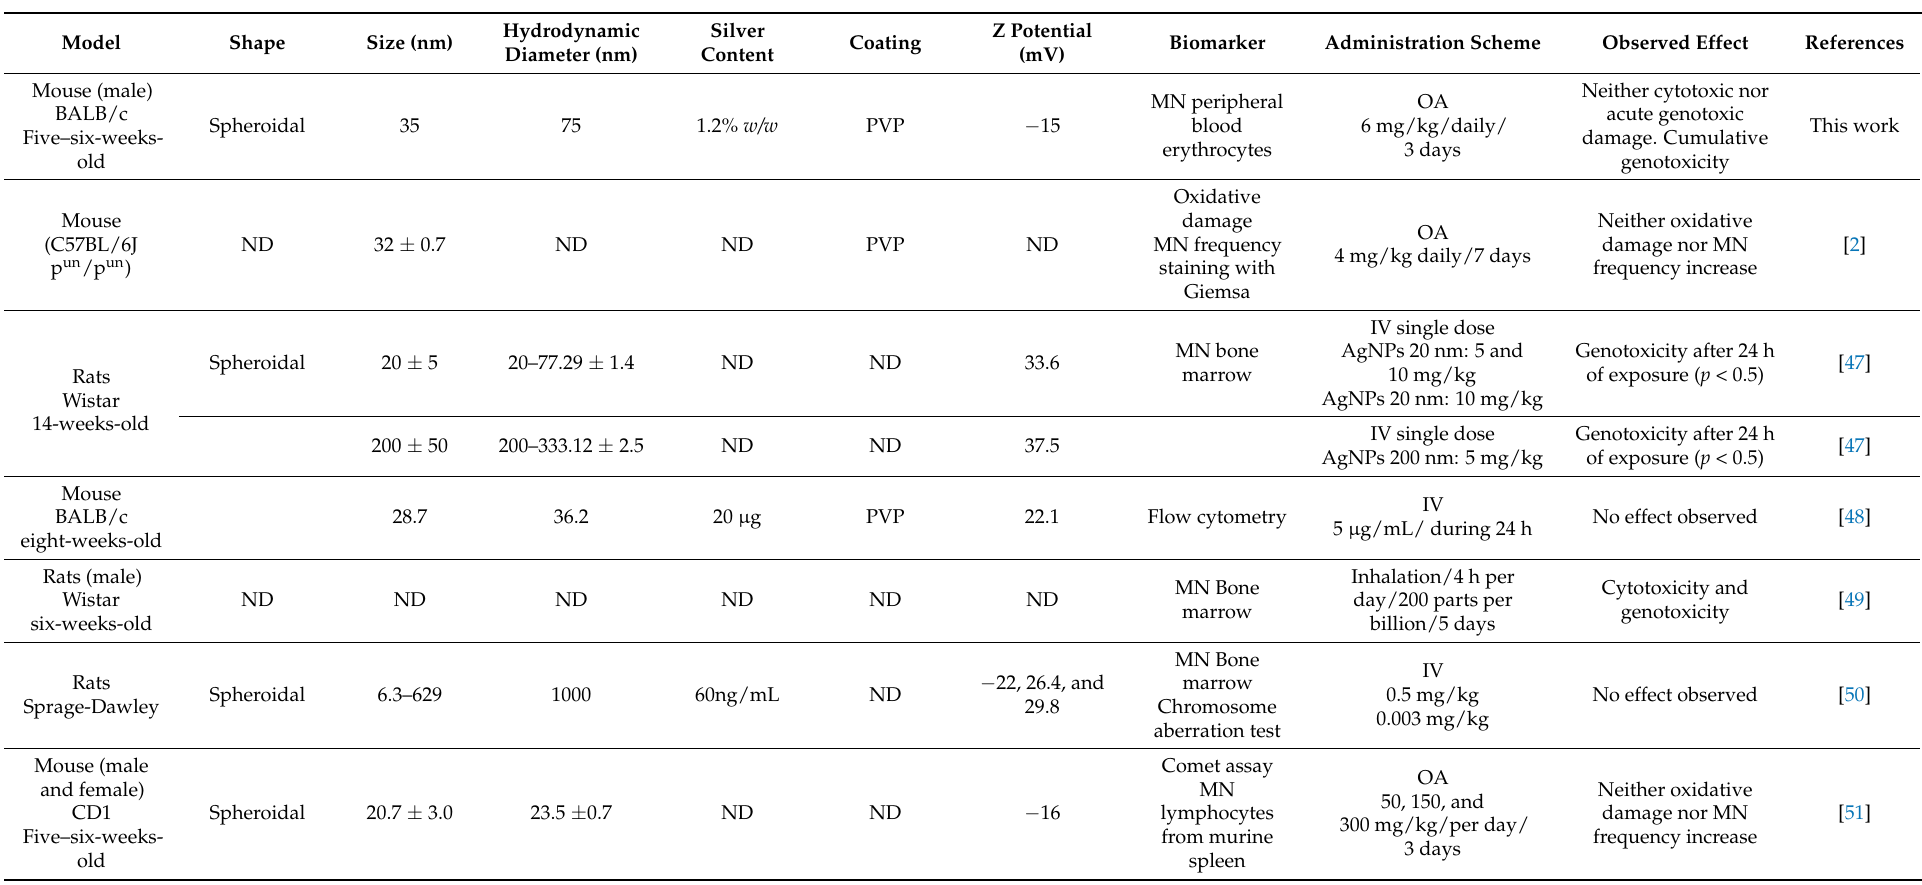
Table 1. Cytotoxicity and genotoxicity studies of AgNPs with the micronucleus assay in rodent